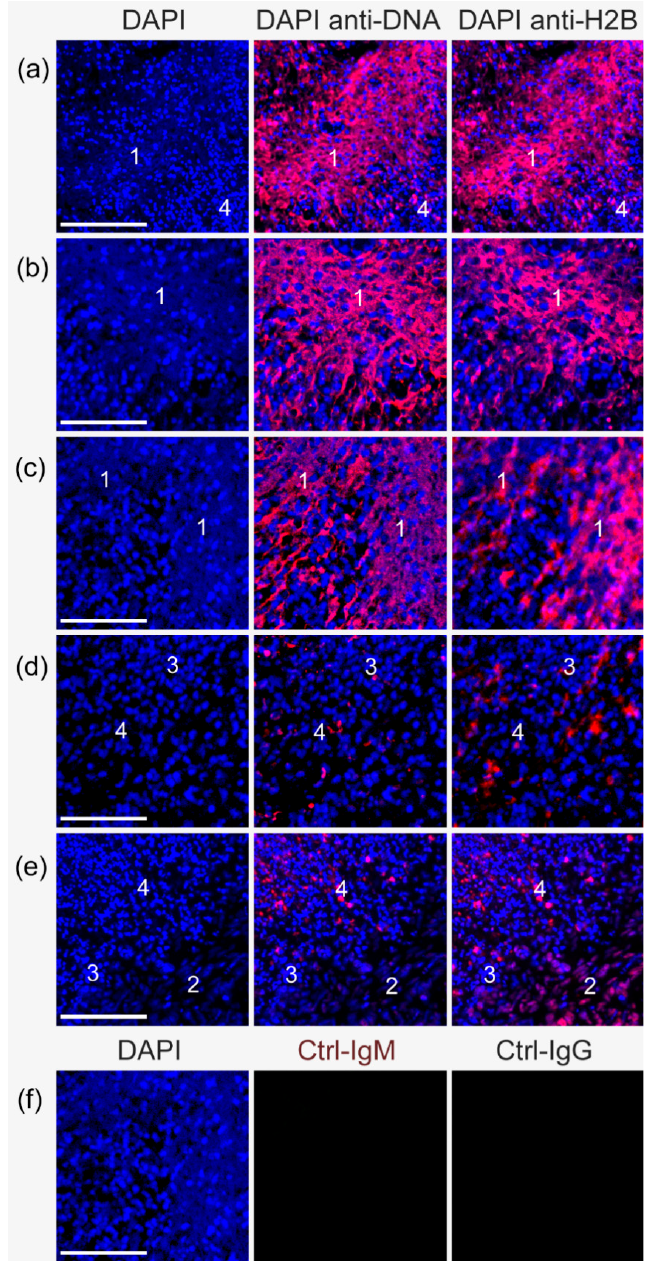
Figure 2. Anti-DNA-IgM antibody staining favors the detection of ecDNA in DNA rich and poor tissue specimens. Epifluorescence and confocal images from colon tumor patients. Stains: DNA by DAPI (blue) and chromatin by anti-DNA-IgM-TRITC and anti-H2B-IgG-Cy5 (both displayed in red). ( a – c ) extracellular DNA-rich and ( d , e ) extracellular DNA-poor tissue sections are displayed. (1) Anti-DNA-IgM presents an intensive fluorescence signal in the extracellular environment that co-localized with anti-H2B-IgG. (2) Anti-H2B-IgG also stains intranuclear decondensed chromatin. The co-localization of anti-H2B and anti-DNA-IgM confirms its nature as NETs-borne decondensed chromatin. Cells with condensed DNA in their nuclei show a high DAPI signal and (3) no or (4) faint anti-DNA-IgM and anti-H2B-IgG signal. ( f ) isotype control staining. Scale bar = 100 µm.